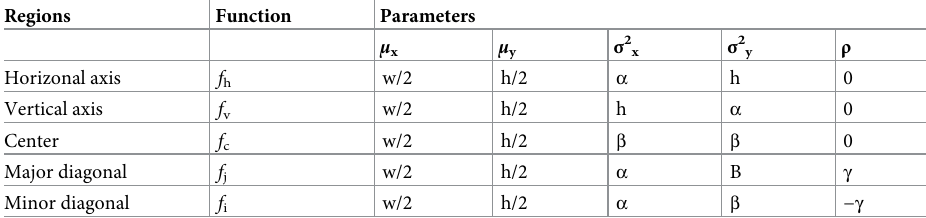
Table 1. Density functions for the different regions and corresponding parameter values in terms of the three model parameters α , β , and γ , and the width (w) and height (h) of the area. Regions